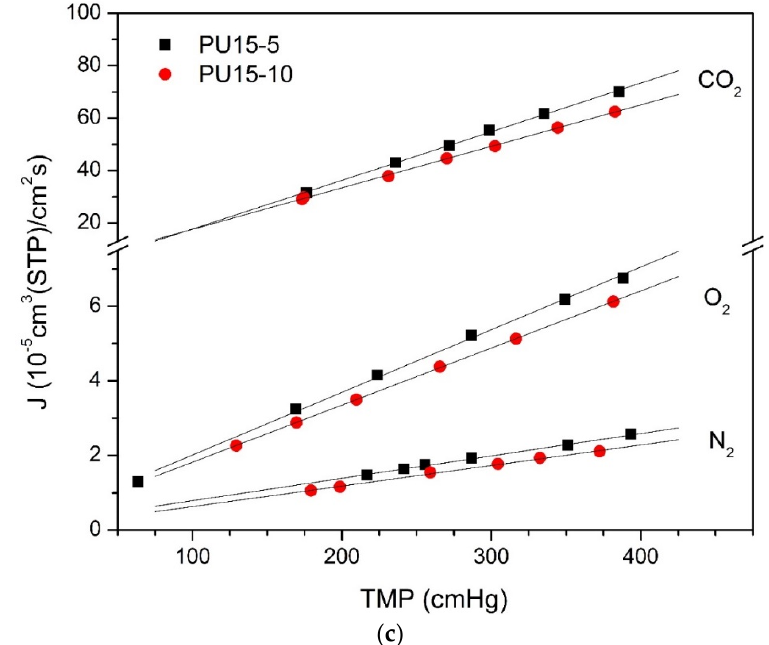
Figure 8. Volumetric flux ( J ) vs. TMP for the integral asymmetric membranes from group 2. Black squares represent data for membranes prepared with 5 min of solvent evaporation time and red circles data for those of 10 min. The lines are least squares fits of the points. In ( a ) data for the membranes containing 5 wt% PCL, in ( b ) data for the membranes with 10 wt% PCL, in ( c ) data for the membranes with 15 wt% PCL. Table 5. N 2 , O 2 , and CO 2 permeances of the integral asymmetric membranes from group 2: